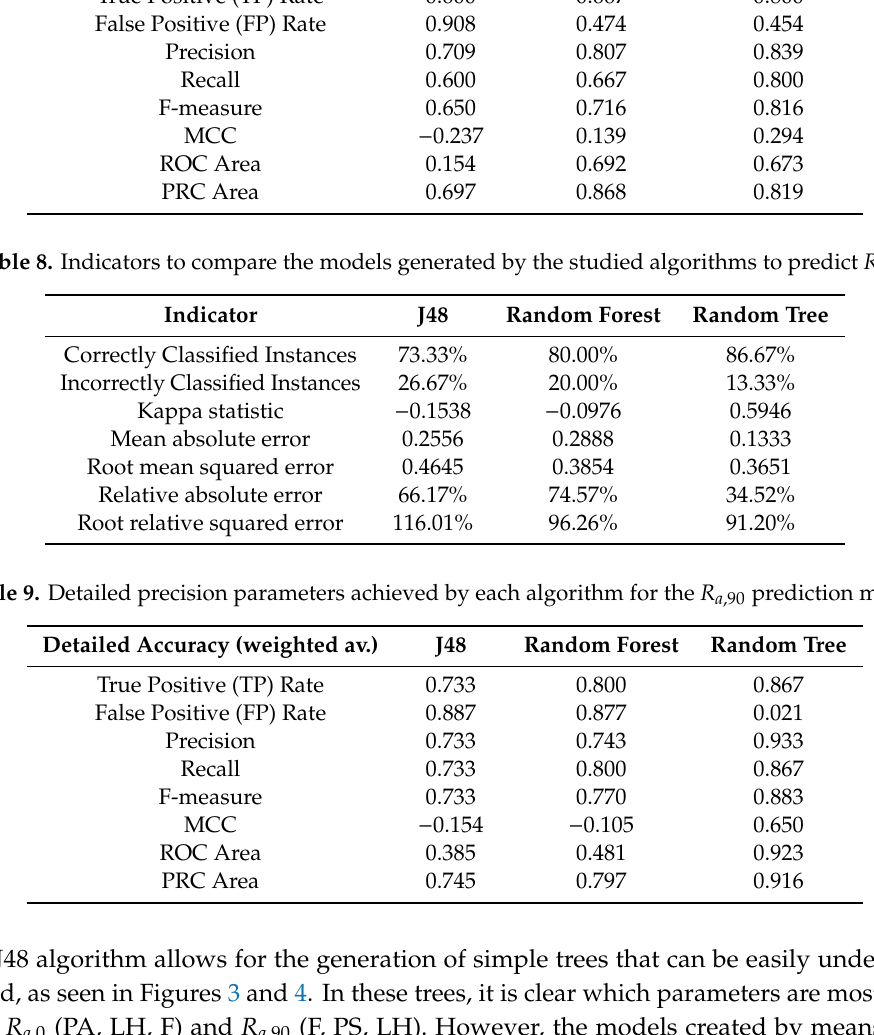
Table 7. Detailed precision parameters achieved by each algorithm for the R a ,0 prediction model. Detailed Accuracy (weighted av.)